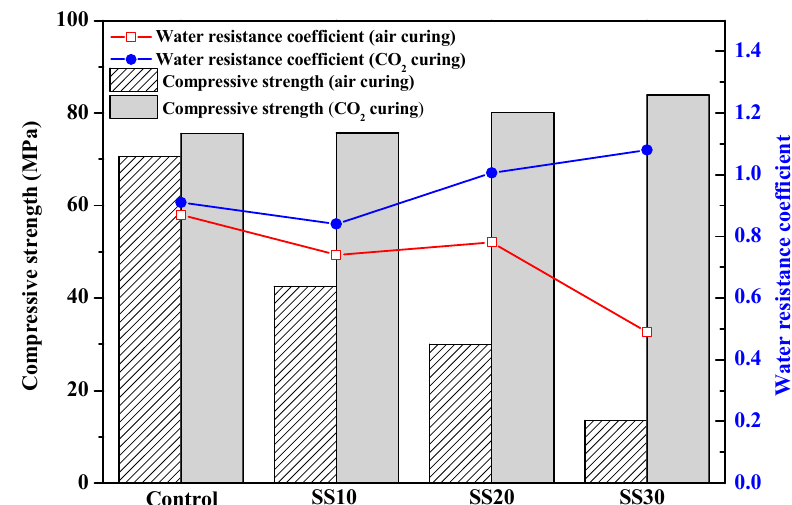
Figure 4. Compressive strengths and water-resistance coefficient of the control, SS10, SS20, and SS30 with and without CO 2 treatment after water immersion for 28 days.